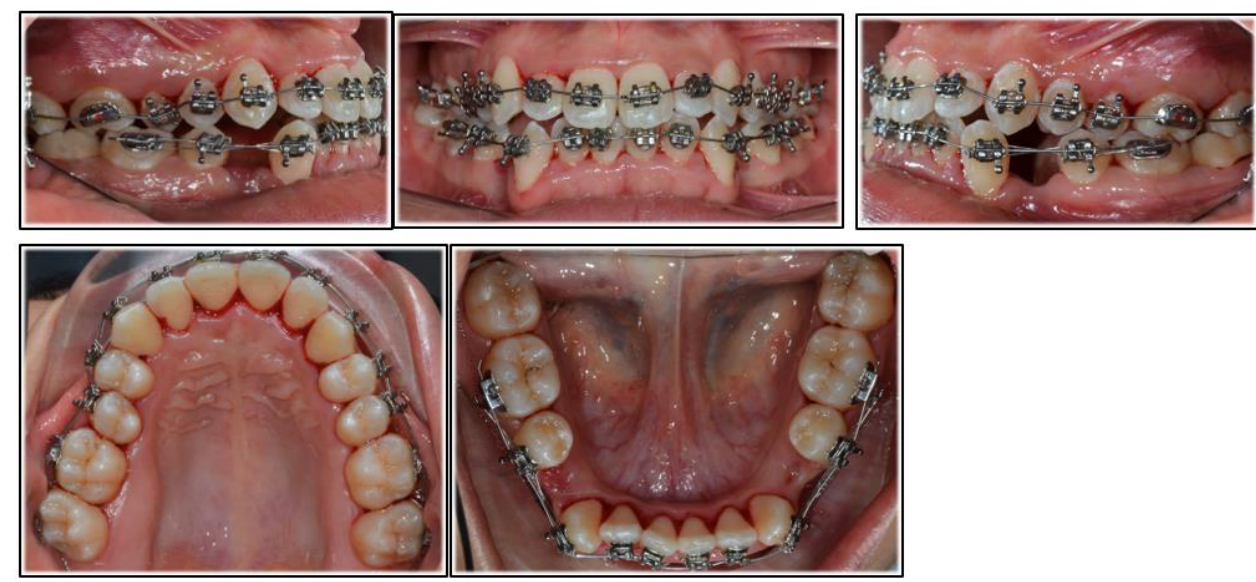
Figure 2. Extractions of 34 and 44 and initial leveling and alignment with 0.16 CuNiTi.